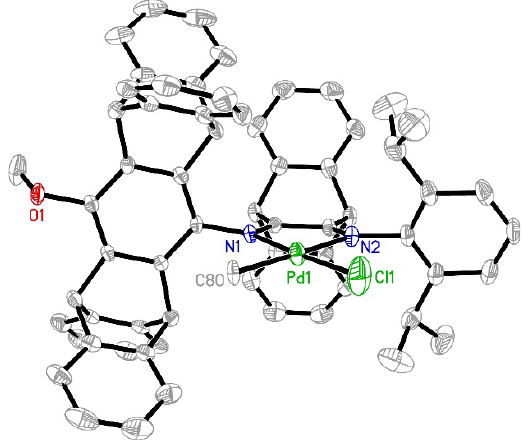
Figure 2. Molecular structure of Ipty/ i Pr-Pd drawn with 30% probability ellipsoids. Hydrogen atoms and one CH 2 Cl 2 molecule are omitted for clarity. Selected bond lengths (Å): Pd1–Cl1 2.280(2), Pd1–C80 2.084(5), Pd1–N1 2.063(4), Pd1–N2 2.151(5).